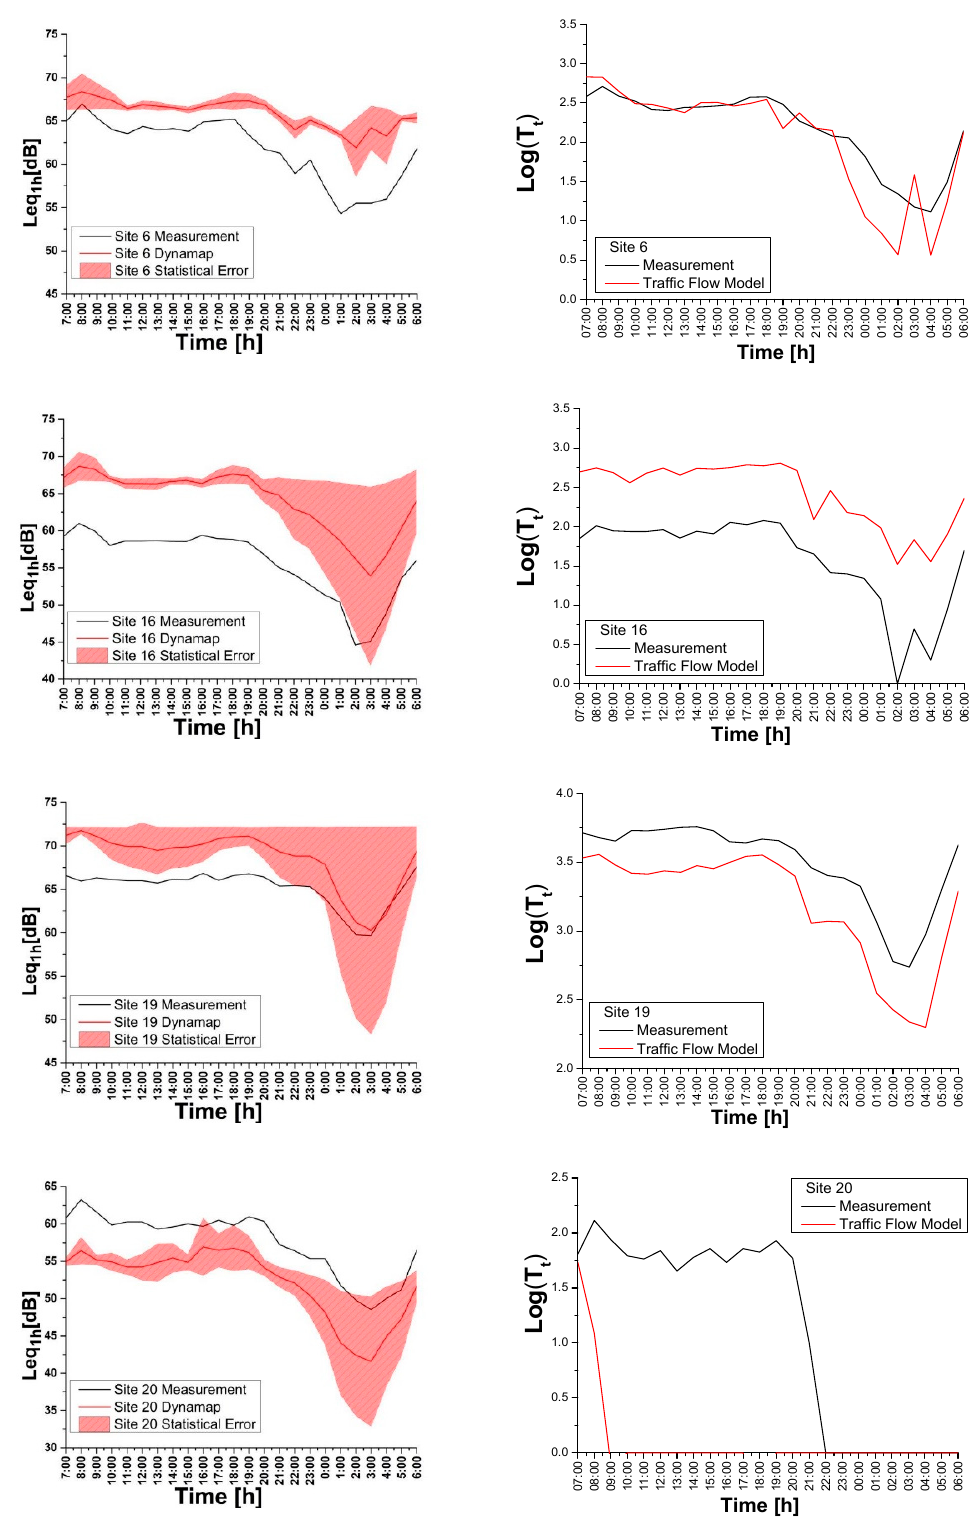
Figure 14. (Left side) Comparison between traffic noise measurements and DYNAMAP predictions at: Site 6 (group g = 3), Site 16 (group g = 4), Site 19 (group g = 6), Site 20 (group g = 1). The colored band represents the 1 σ confidence level. (Right side) Comparison between traffic flow measurements and AMAT traffic model at the same sites.